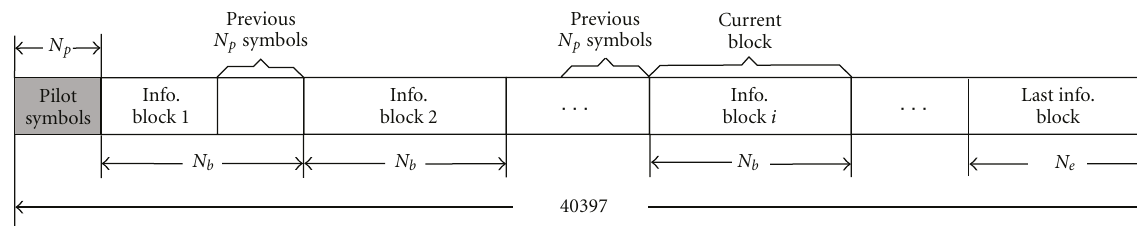
Figure 13: Partition of the transmitted data payload for block detection at the receiver.